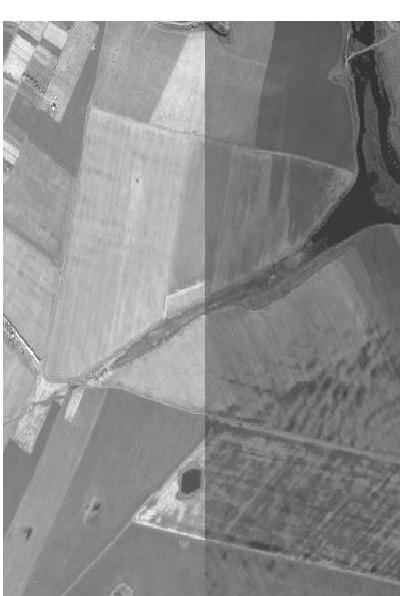
Figure 10. Final strip mosaic.